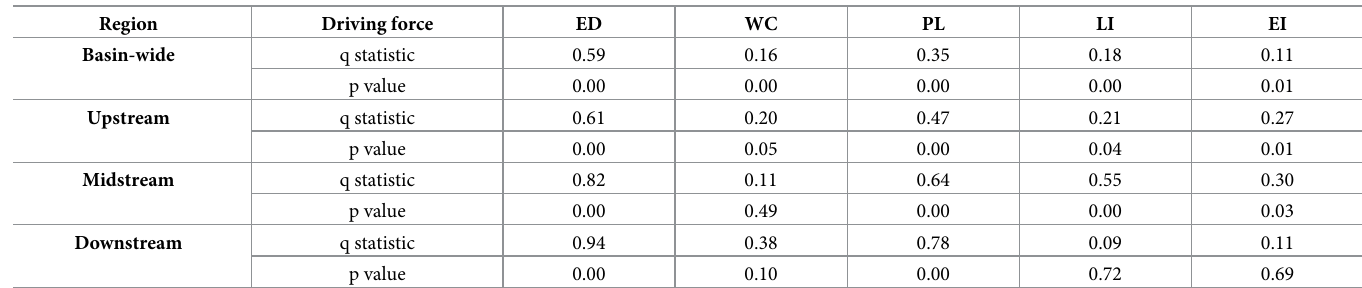
Table 2. The driving force of internal factors on the GWF efficiency. Region